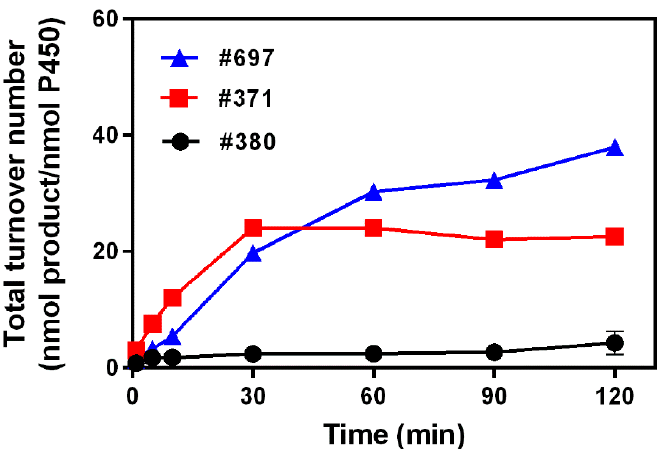
Figure 6. Time profiles of 6 ′ a-hydroxymethyl-monacolin J formation , which was catalyzed using M380, M371, and M697. TTN values were determined using HPLC after accomplishing the reactions at indicated times at 37 °C. The formation of 6 ′ a-hydroxymethyl monacolin J was measured in the reaction mixtures containing 0.2 μ M of P450, an NADPH regeneration system, and monacolin J (0.30 mM) for a total volume of 0.25